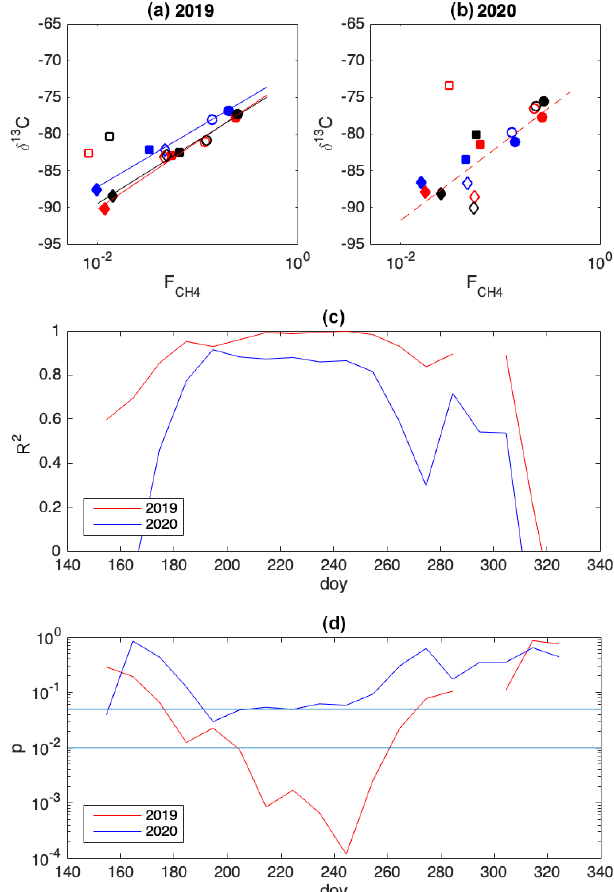
Figure 8. (a, b) Examples of spatial variation in 10d averages of δ 13 C-CH 4 against F CH , during three 10d time periods in 2019 and 4 2020. Chambers: 1, solid circles; 2, open circles; 3: open squares; 4: solid diamonds; 5: open diamonds; 6: solid squares. Colors of markers and lines indicate the period: day of year (doy) 210–219, red; doy 220–229, blue; doy 230–239, black. The solid lines indi- cate correlation with p < 0 . 01 and the dashed line with p < 0 . 05. (c) R 2 between 10d averages of δ 13 C and F CH , without chamber 4 3. (d) p value of correlation, without chamber